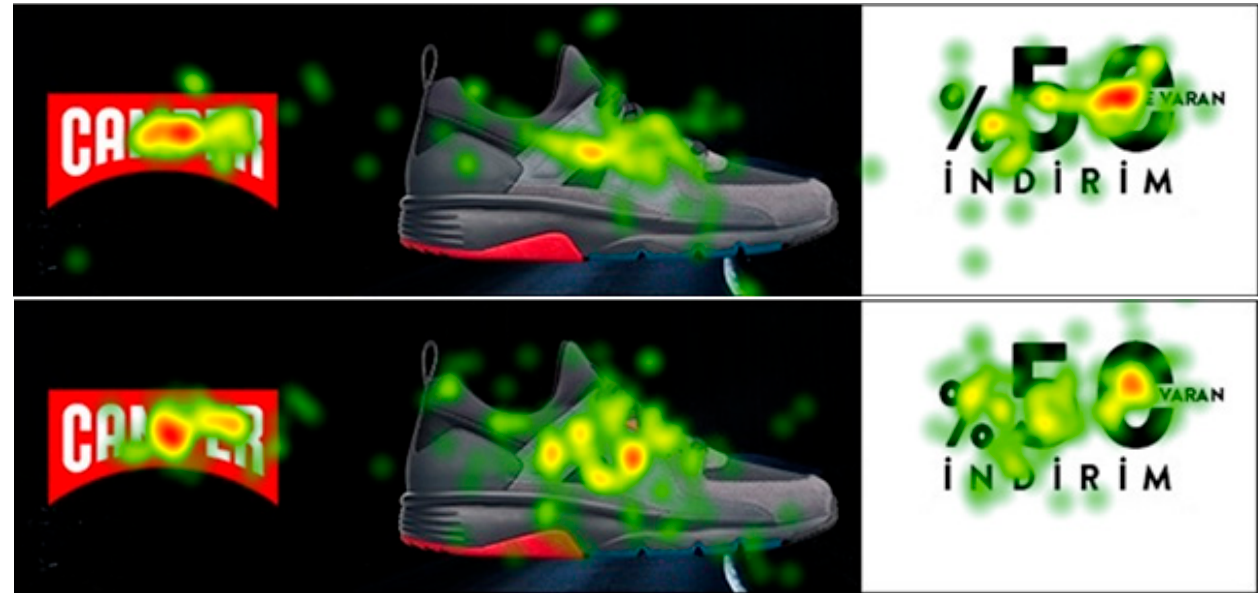
Figure 6. Heat maps for the participants who were familiar ( above ) and unfamiliar with the brand ( below ).